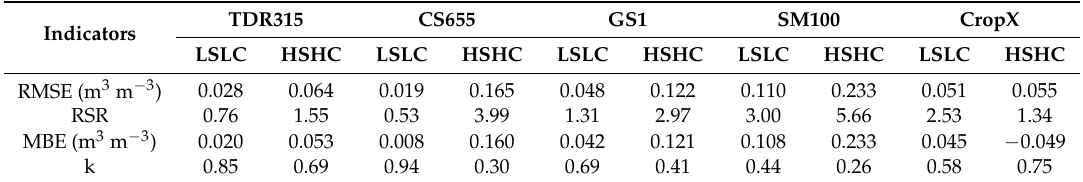
Table 3. Performance indicators of soil moisture sensors.